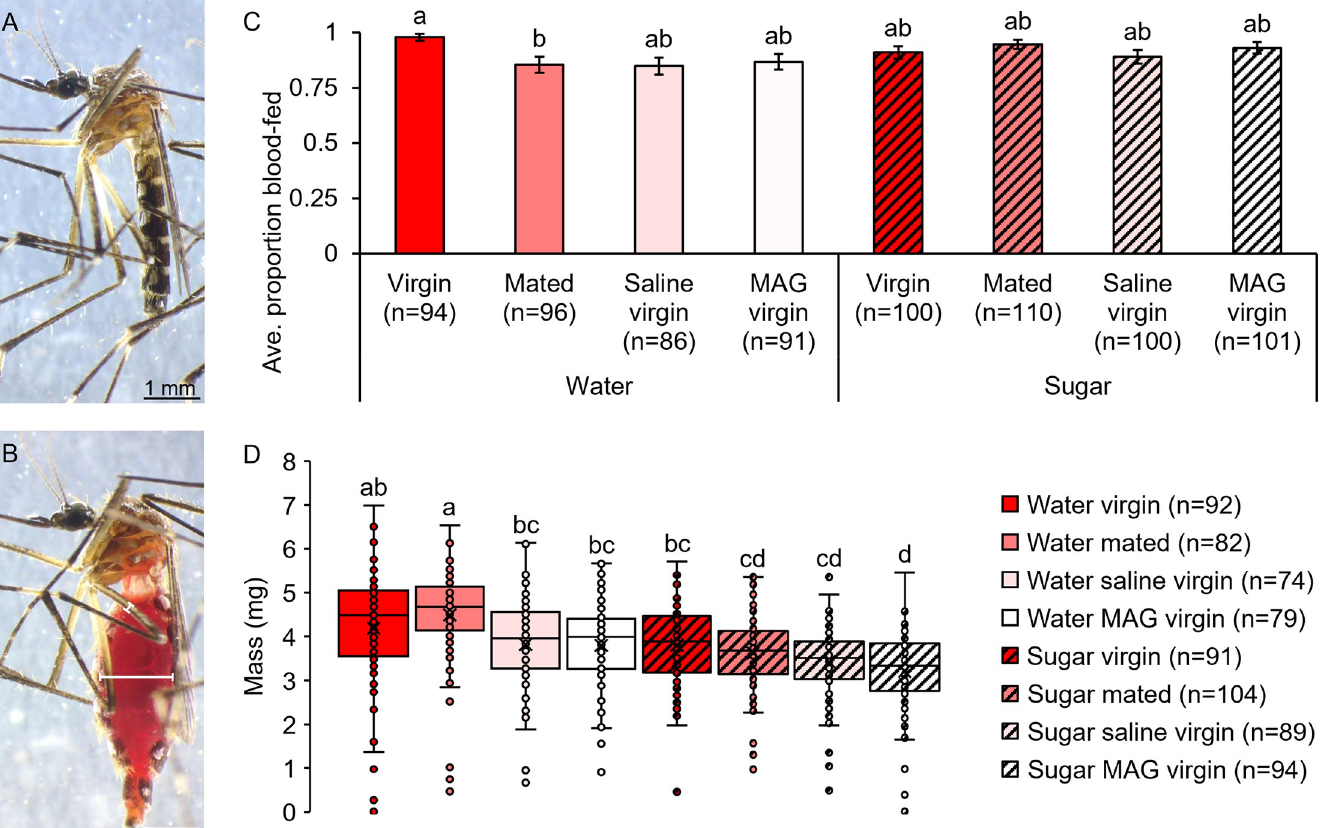
Fig 1. Mating and MAG do not affect initial blood meal size, but sugar feeding does. The masses of non-blood-fed (A) and blood-fed (B) females were used to determine the initial blood meal size. White bars in panel B illustrate ISD and femur width measurements used for blood meal engorgement estimates presented in S7 and S8 Figs. Feeding avidities were similar regardless of mating and sugar feeding status (C). Although mating and MAG injection did not affect blood meal size compared to non-injected and saline-injected virgin controls, prior sugar feeding resulted in smaller blood meals (D). Error bars in panel C denote SE of sample proportions and whiskers in panel D denote the minimum and maximum values. Box plots display the boundaries of the first (bottom) and third (top) quartiles, median lines, mean markers (“x”), and individual data points, including outliers. Letters above columns and box and whisker plots denote H-B-corrected post-hoc comparison p-values, with differing letters indicating significantly different